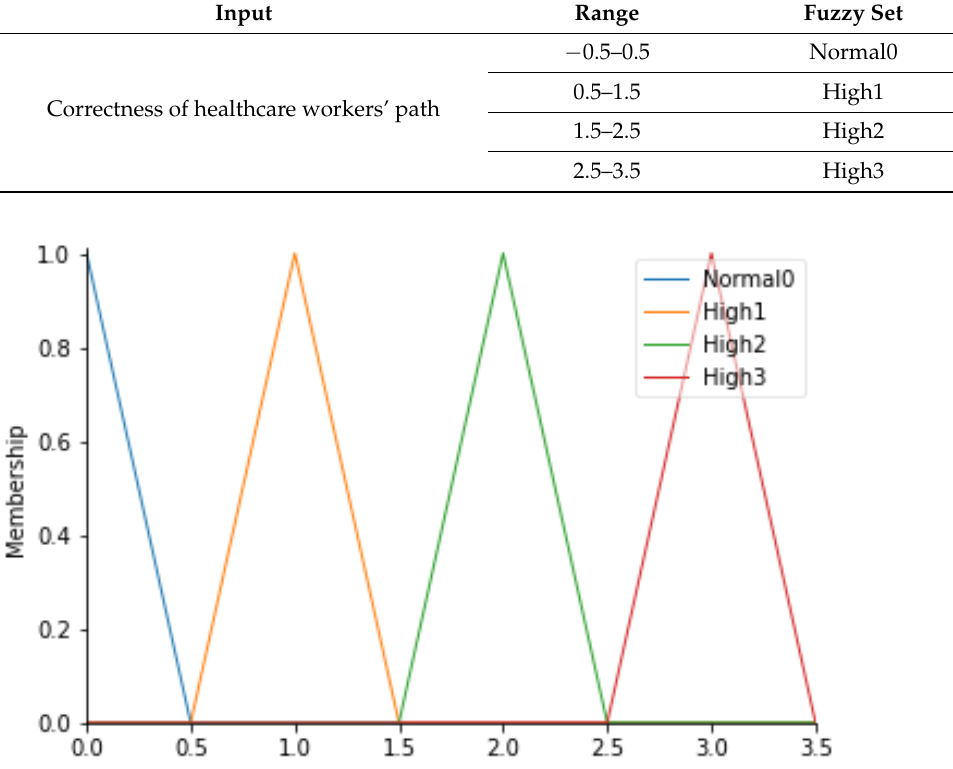
Table 7. Ranges of HWP and their respective fuzzy sets.